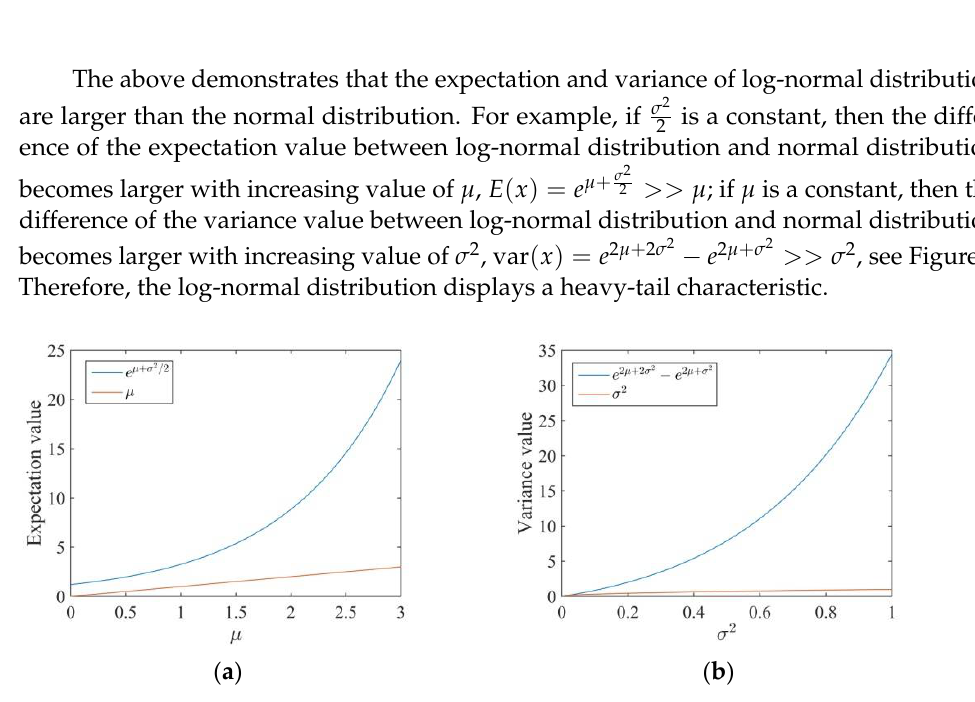
Figure 1. Comparison of the ( a ) expectation value and ( b ) variance between log-normal distribution and normal distribution. In ( a ), σ = 0.6; in ( b ), µ =